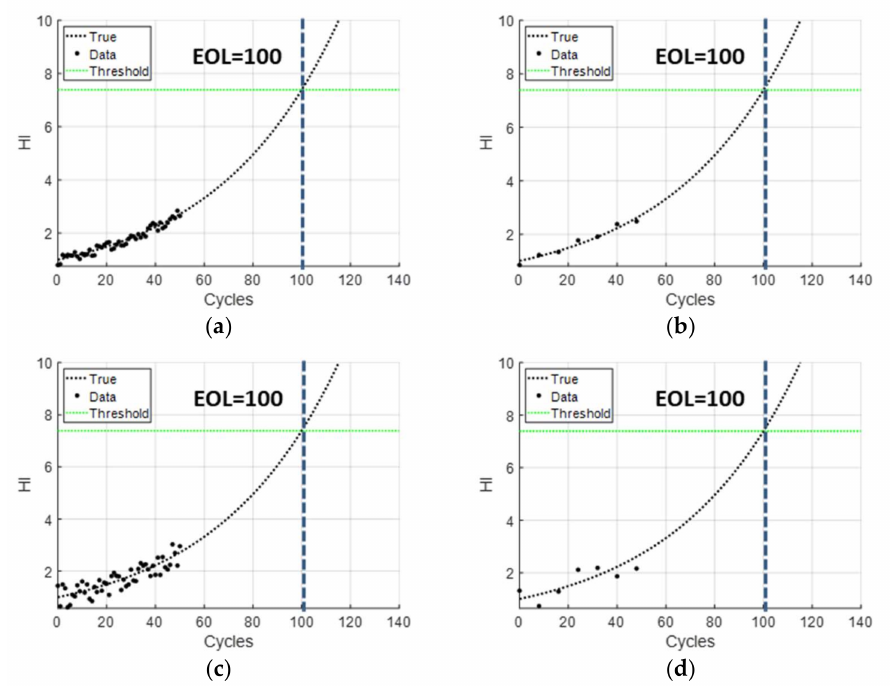
Figure 2. Simulation degradation datasets: ( a ) low noise and large data; ( b ) low noise and small data; ( c ) large noise and large data; ( d ) large noise and small